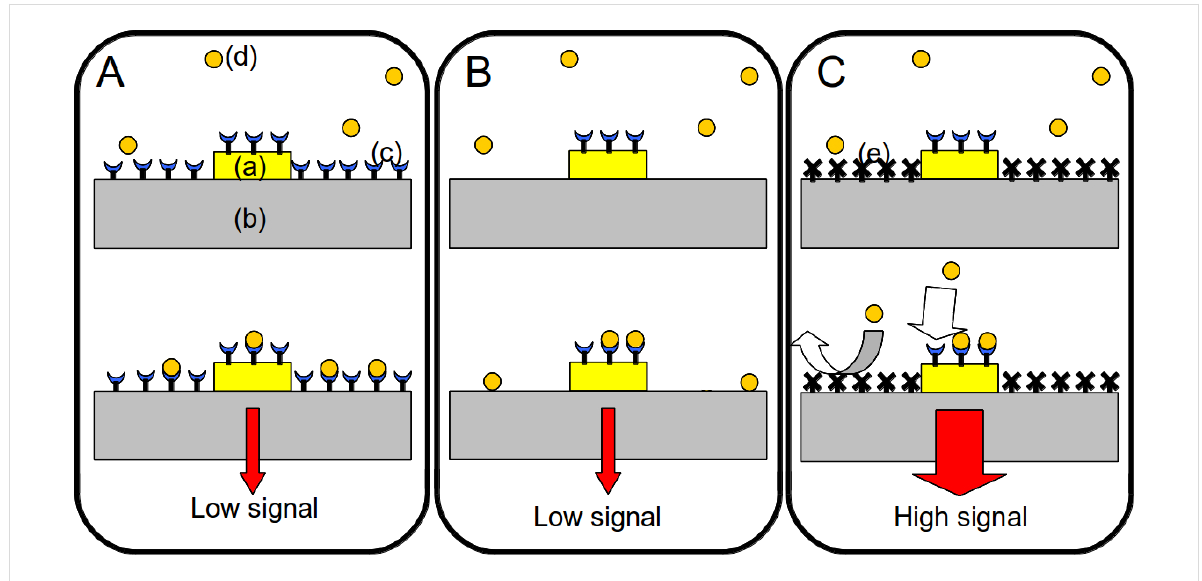
Figure 1: Schematic representation of the use of orthogonal functionalization techniques to enhance the sensitivity of a plasmonic biosensor (with a constant number of molecules). (A) Functionalization is uniform over the entire surface. The immobilization of probes (c) onto the entire surface, including the LSPR zone (a) and silica substrate (b). The targets (d) are captured far from the LSPR area. (B) Only the nanotransducer is functional- ized. Selective immobilization of probes onto the LSPR area (a) only. The targets can absorb onto the silica substrate (b) far from the LSPR zone. (C) Orthogonal functionalization on the nanotransducer and surrounding surface. Selective immobilization of probes onto the LSPR area only, and selective nonfouling treatment (e) on the silica substrate. The targets only bind to the enhanced detection